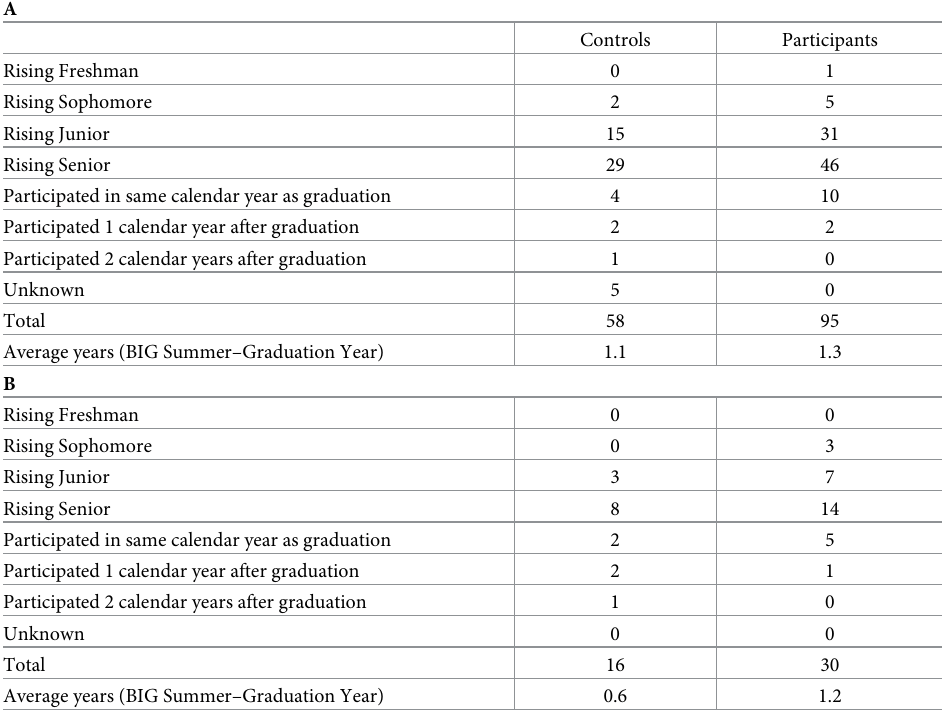
Average years (BIG Summer–Graduation